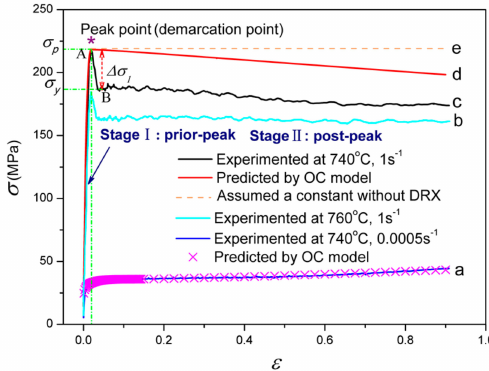
Figure 1. Typical true stress-true strain